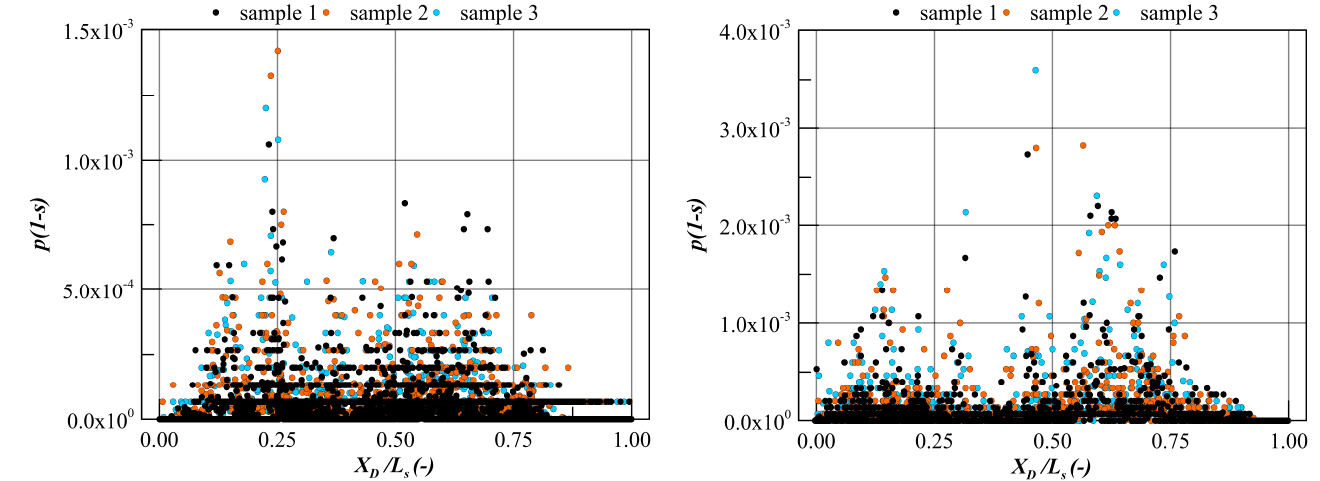
Figure 2. Static risk profile for a cruise ship ( left ) and a Ro-pax ( right ).